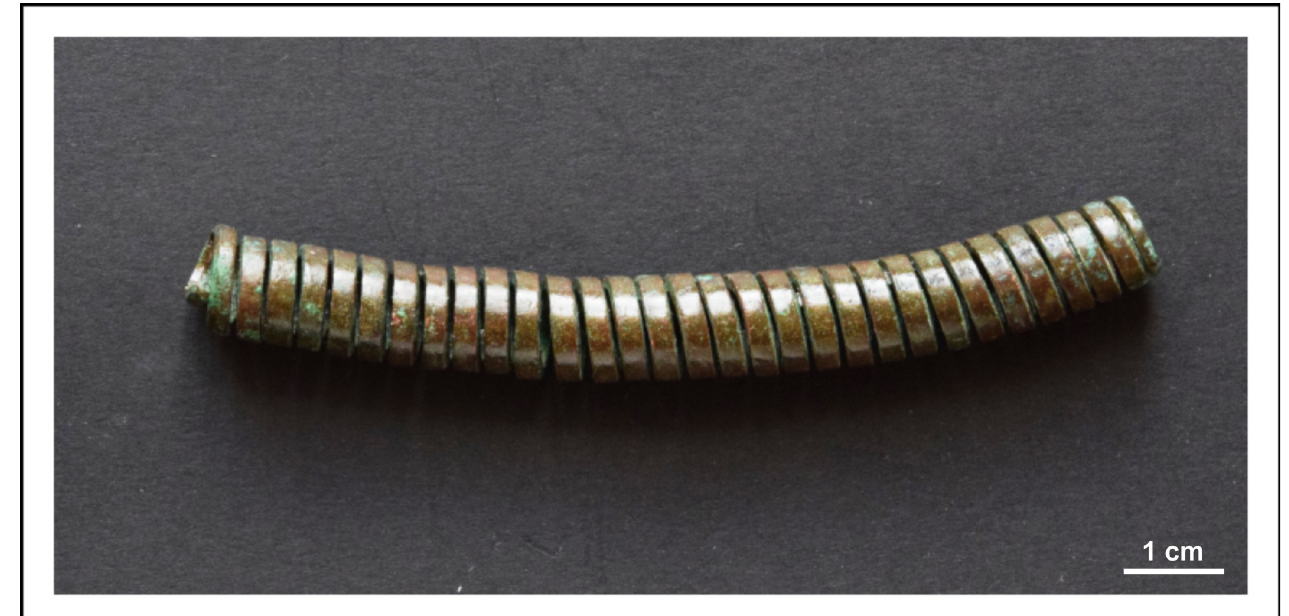
Fig 7. An example of tubular spiral coils. Photo: Pe´ter